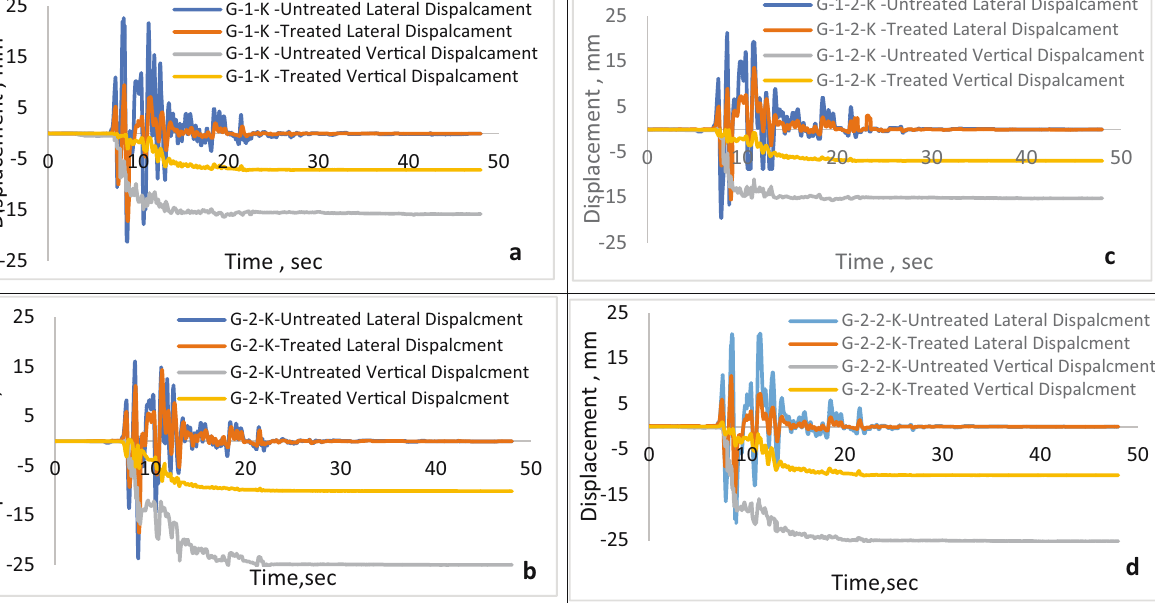
Figure 4: Vertical and lateral displacements of the pile group in the treated and untreated soil with nano - clay at ( a ) 50% axial load, ( b ) 100% axial load, ( c ) 50% axial load and 100% lateral load, and ( d ) 100% axial load and 100% lateral